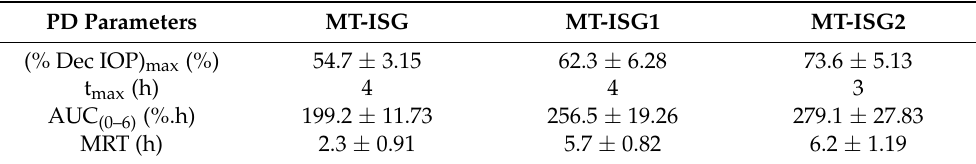
Figure 6. The mean percent decrease in IOP–time profiles following a single ocular dose of MT-ISG, MT-ISG1, and MT-ISG2 in rabbit eyes (mean ± SD, n = 3). Table 3. Parameters of the in vivo effectiveness post-instillation of 0.5 % ( w/v ) MT of different formulations into rabbit eyes ( n = 3, mean ± SD).